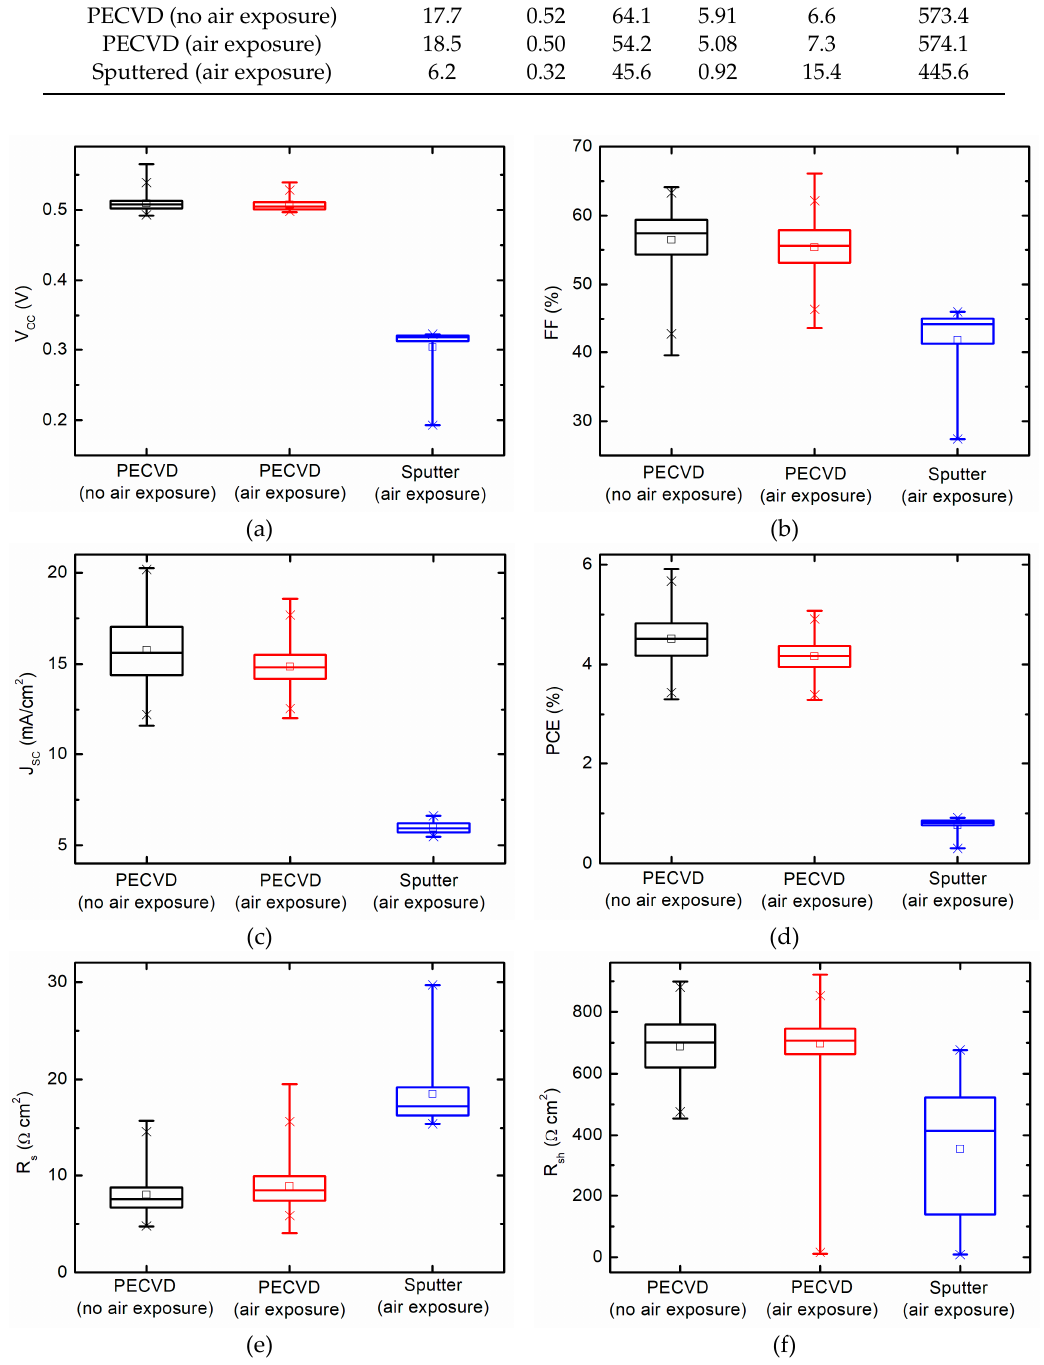
Figure 4. Solar cell performance parameters including open circuit voltage V OC ( a ), fill factor FF ( b ), short circuit current density J SC ( c ), power conversion efficiency PCE ( d ), series resistance R s ( e ), and shunt resistance R sh ( f ) for devices incorporating nc-Si:H absorbers prepared with different methods.